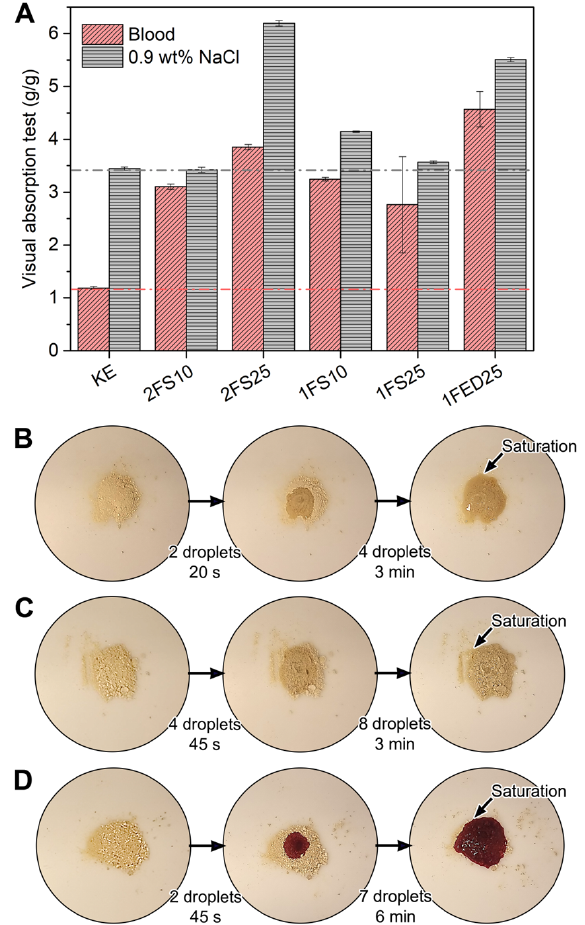
Figure 4. Visual Absorption Test for the samples utilizing blood and saline solution ( A ): the addition of saline until the saturation point for keratin ( B ) and keratin two ‐ stage functionalized with 25 wt% SA ( C ), and of blood for keratin one ‐ stage functionalized with 25 wt% EDTAD ( D ).